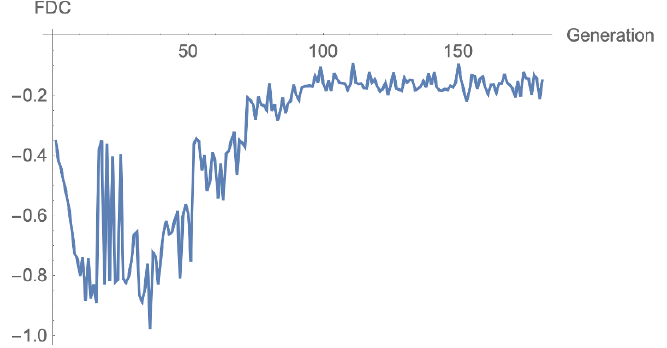
Figure 15 . Fitness distance correlation as a function of